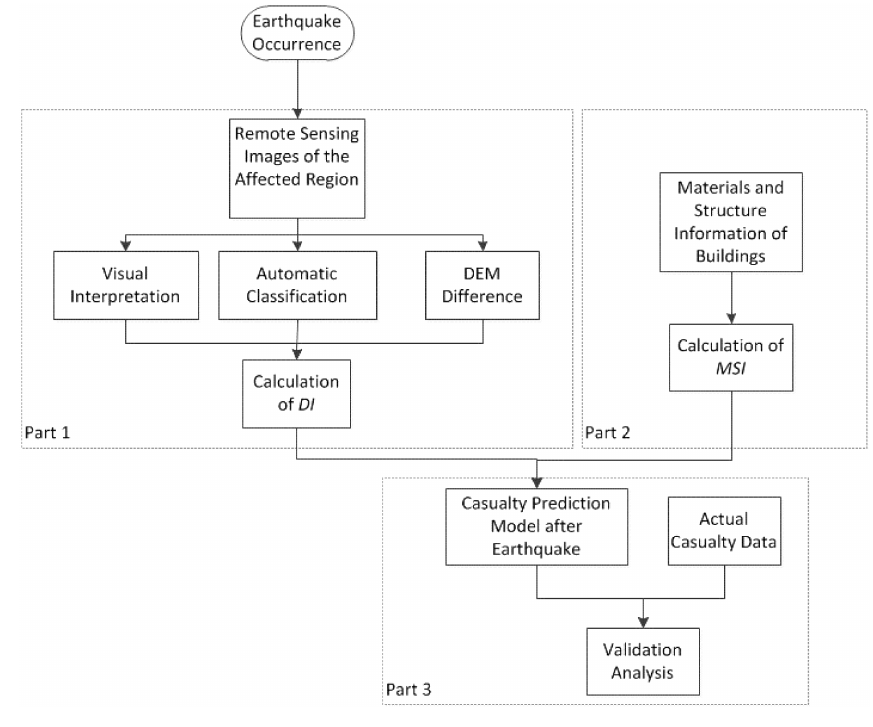
Figure 1. Framework of earthquake casualty estimation.